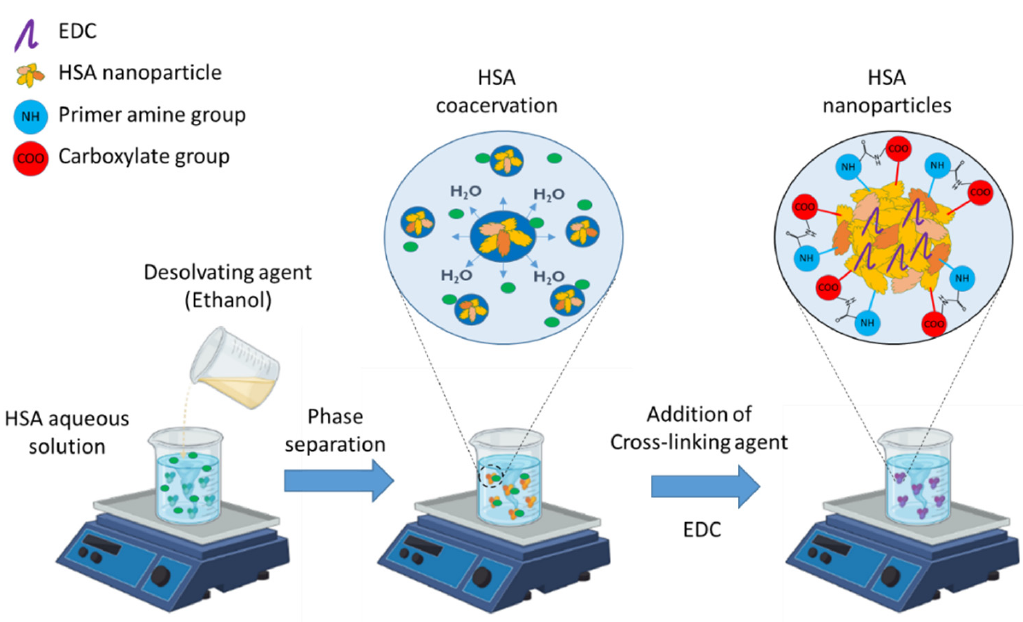
Figure 1. Preparation of HSA nanoparticles.